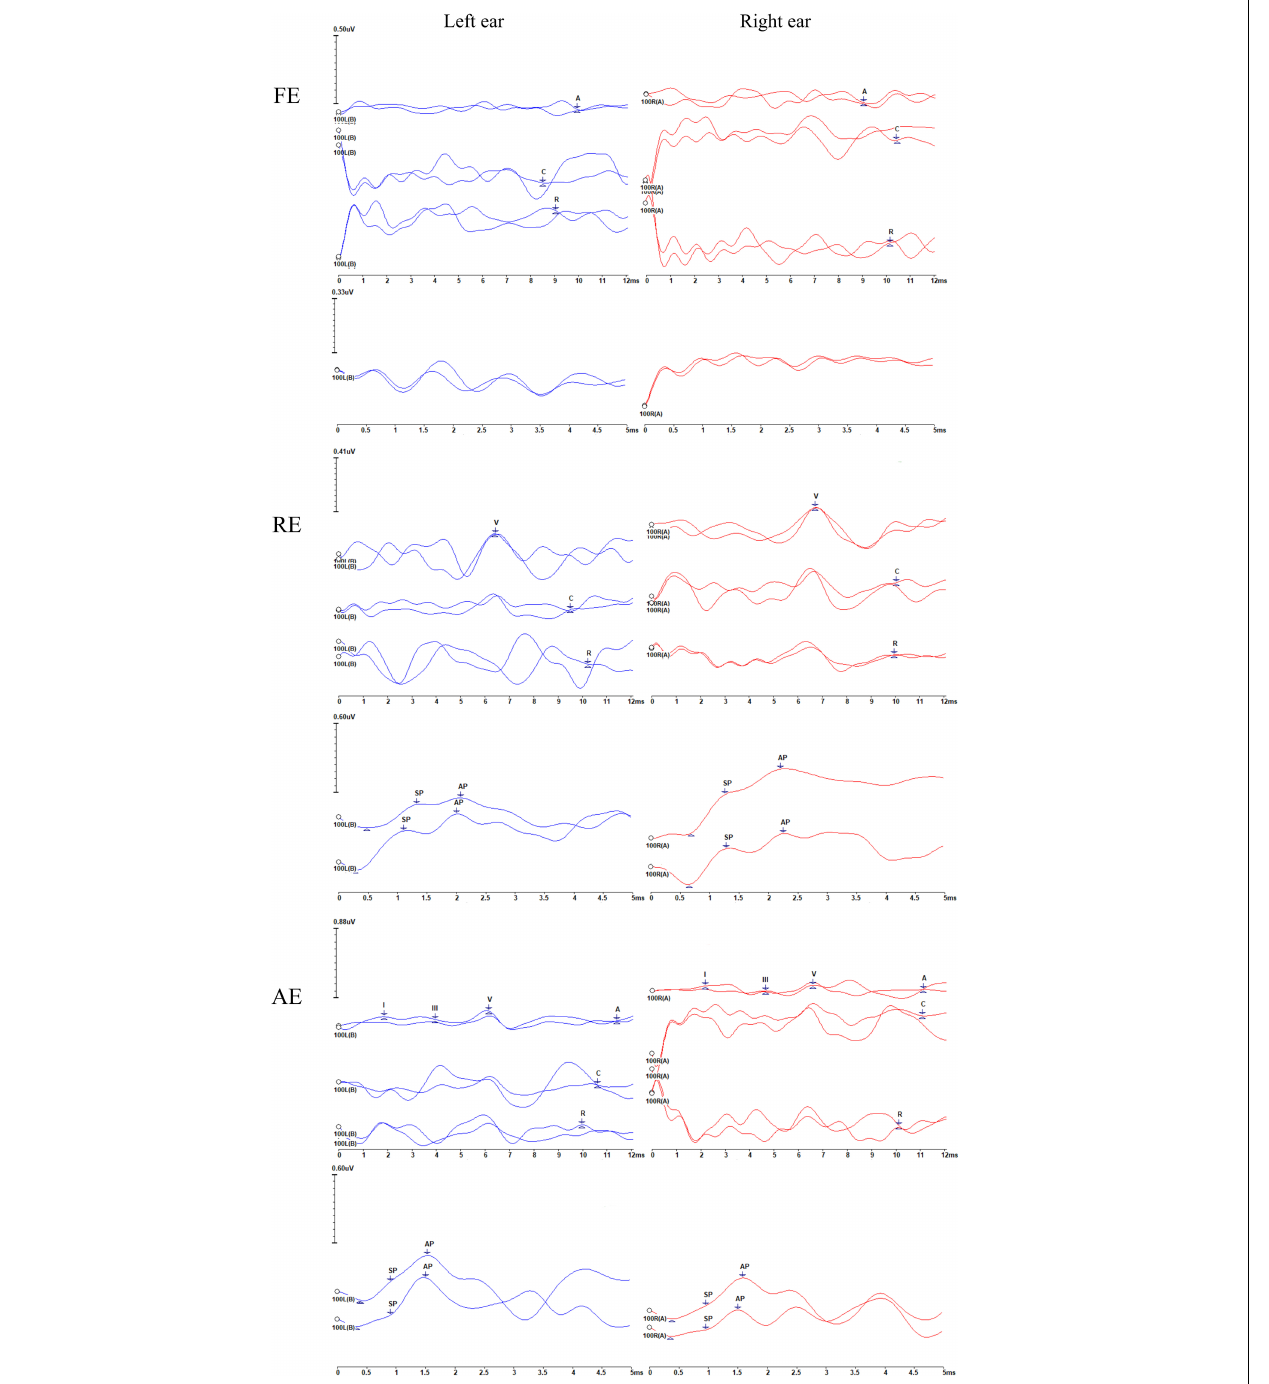
Frontiers in Cell and Developmental Biology |